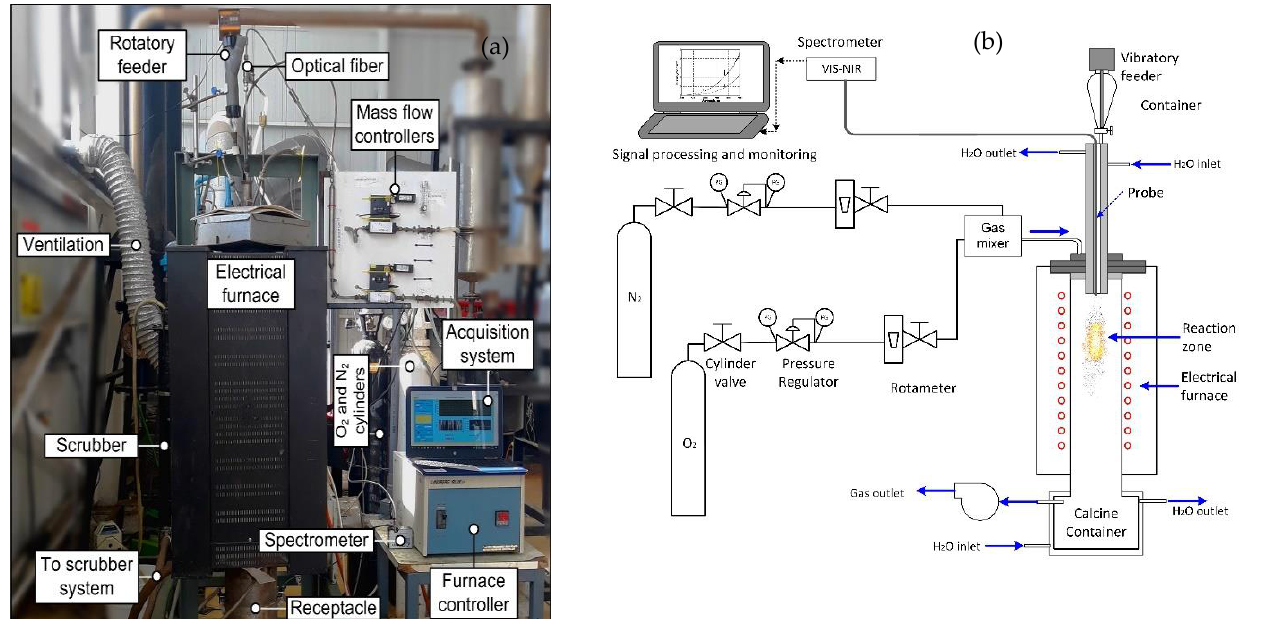
Figure 1. ( a ) Experimental setup [15] and ( b ) schematic diagram.